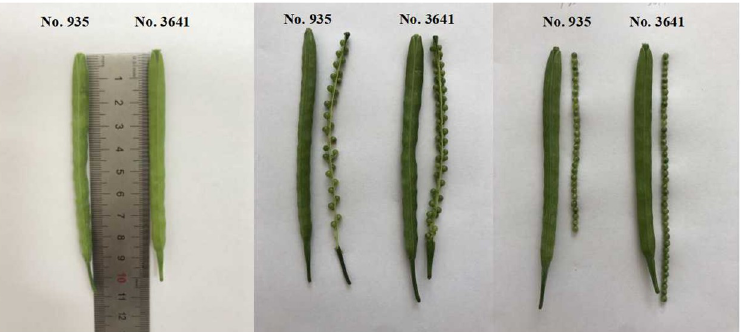
Fig 1. Parental phenotypes. SD was measured as the ratio of the number of seeds per silique to the silique length. (Pedicels and silique beaks are not included in the silique